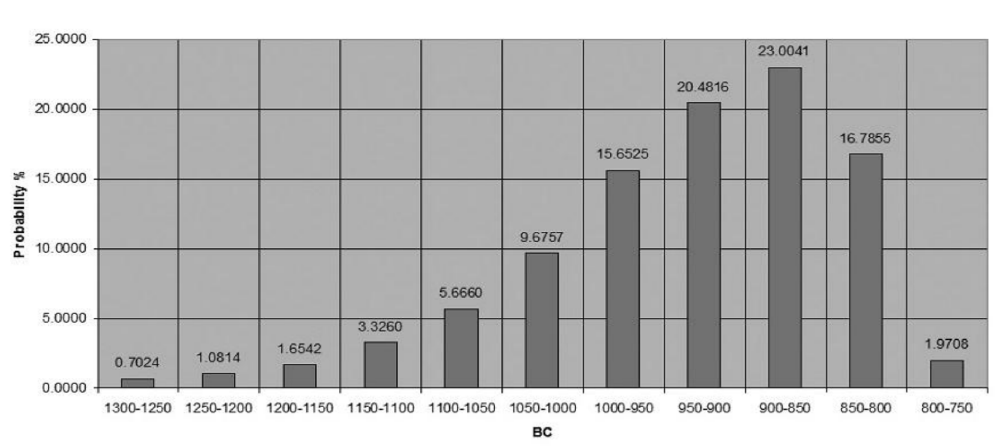
Figure 6 Rate of copper production in Khirbet en-nahas according to the number of radiocarbon determinations* (from Finkelstein 2013, 114, Fig.